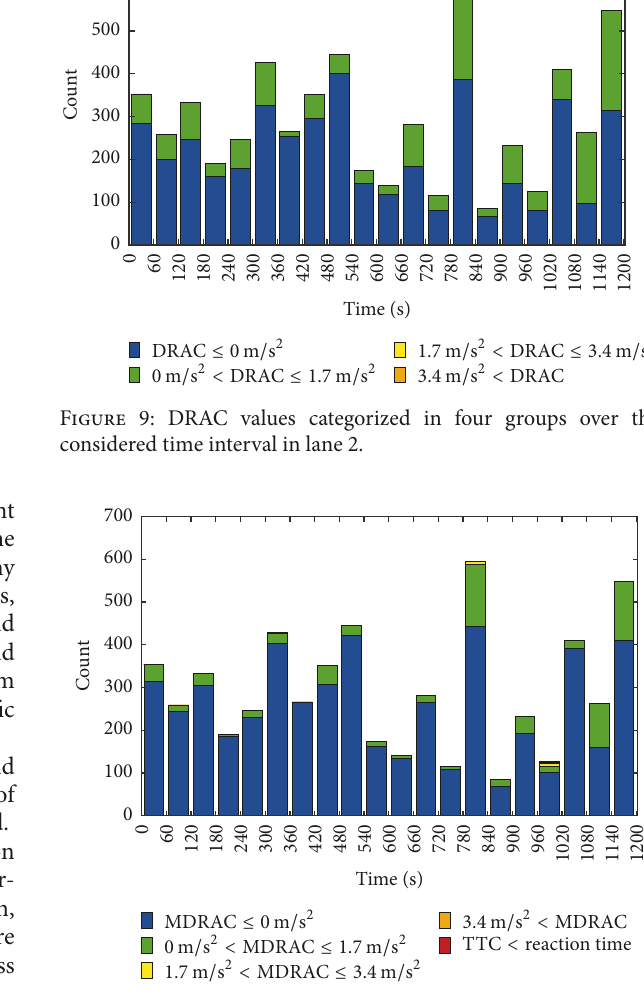
Figure 10: MDRAC values calculated with PRT = 1.3 s categorized in four groups over the considered time interval in lane